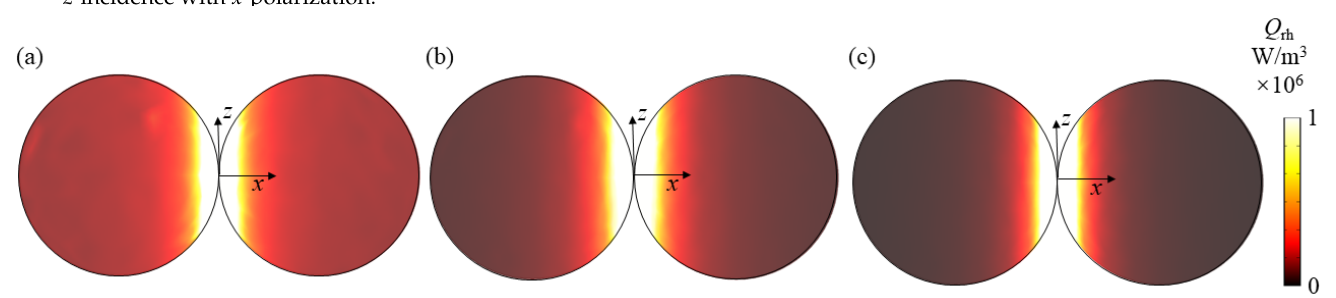
Figure 5. The resistive heat distribution of dimer at ( a ) λ = 430 nm, ( b ) λ = 490 nm and ( c ) λ = 680 nm for z -incidence with x -polarization.